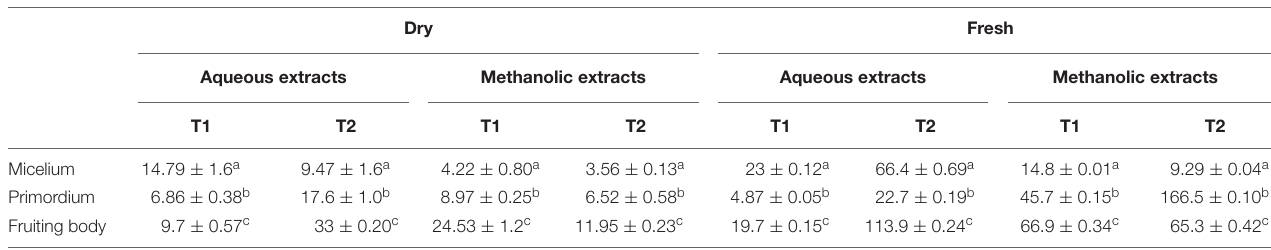
TABLE 3 | Ferric reducing antioxidant power (FRAP) of P. ostreatus.